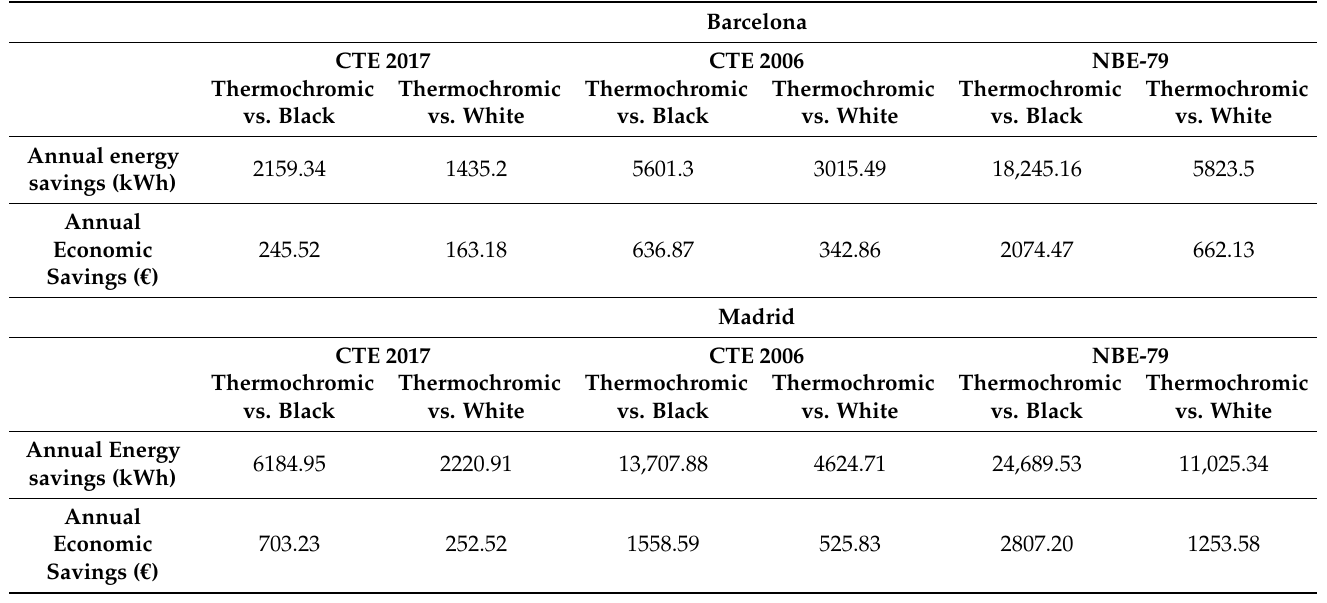
Table 7. Summary of the annual energy savings and economic savings for each case study when a thermochromic was applied vs. black and white surface